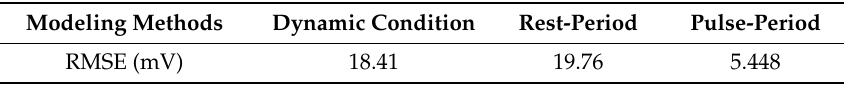
Table 4. RMSE of model voltage estimation under the CC charging